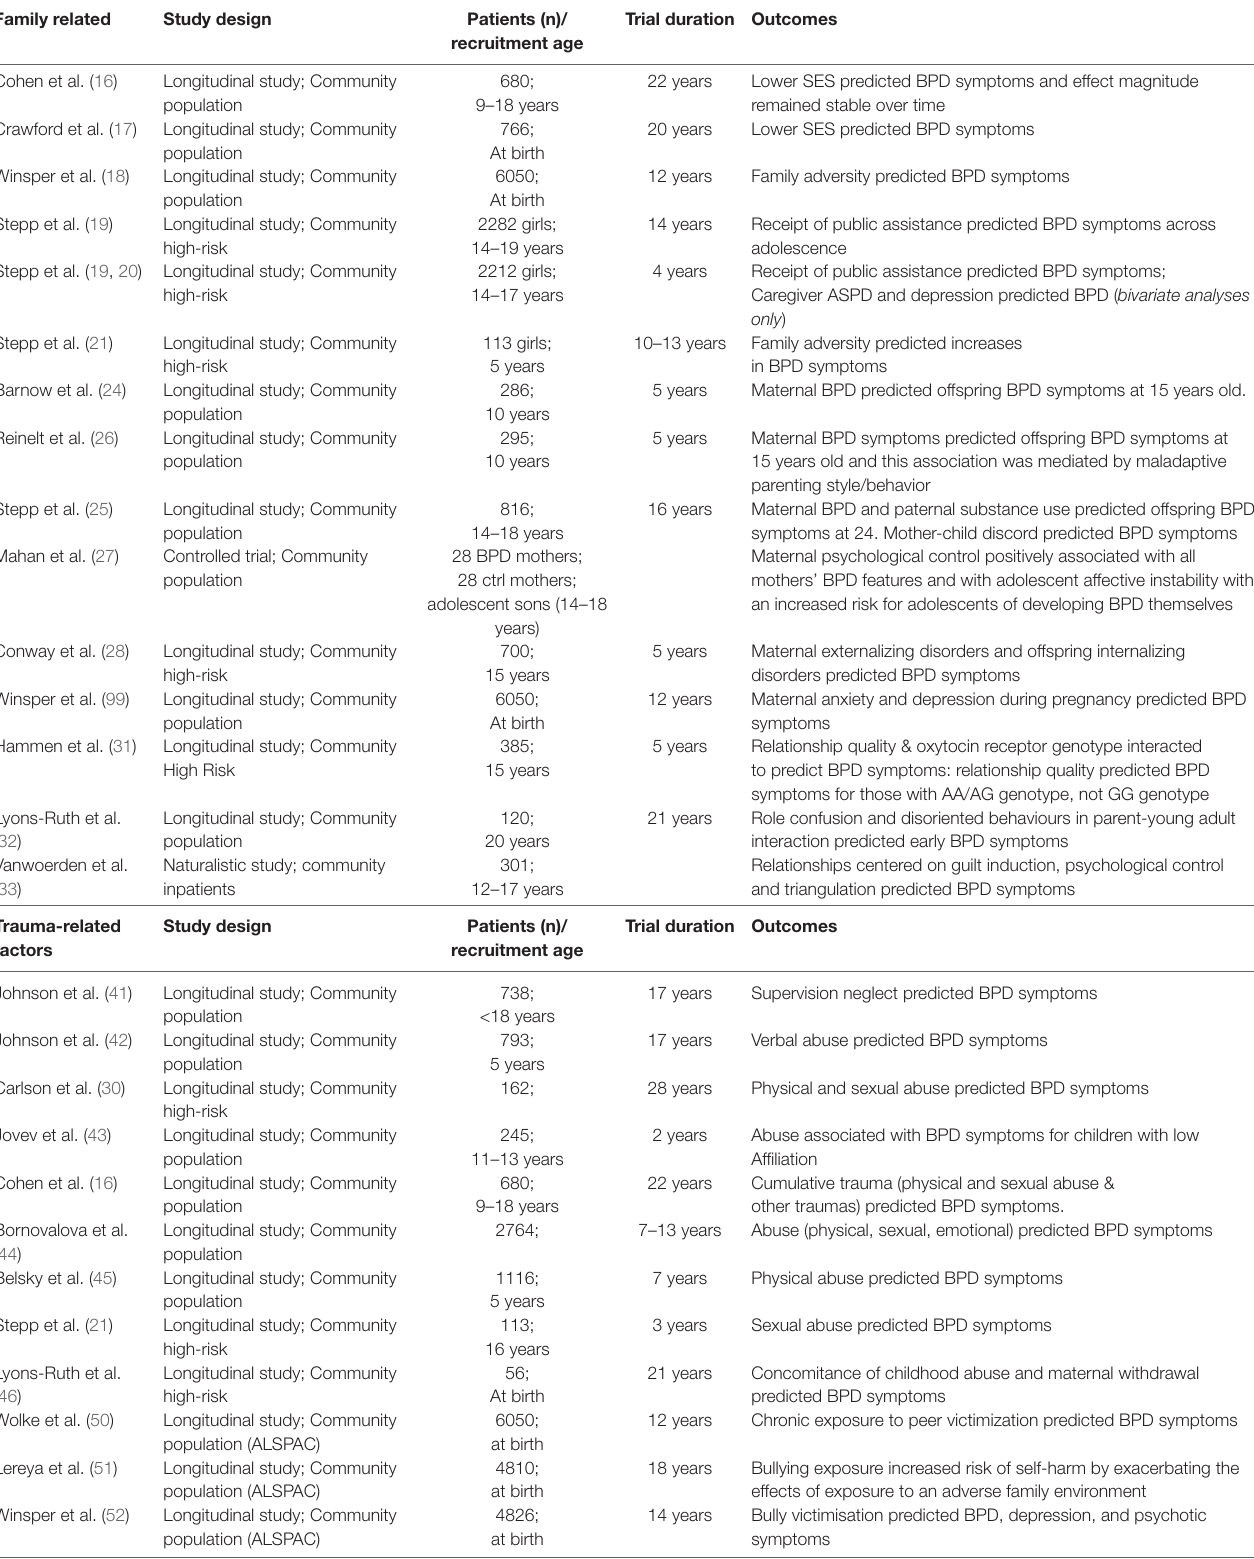
TABLE 1 | Summary of studies on precocious environmental